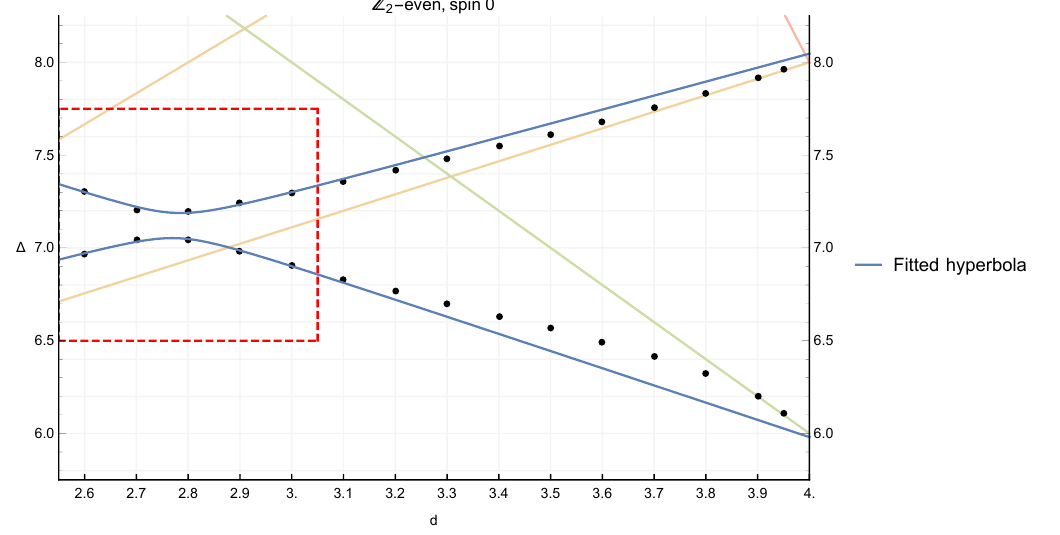
Figure 4 . Magnified version of figure 2, focusing on the level repulsion effect. The blue curve is given by equation (4.9) and has been fitted using the operator dimensions in the red box